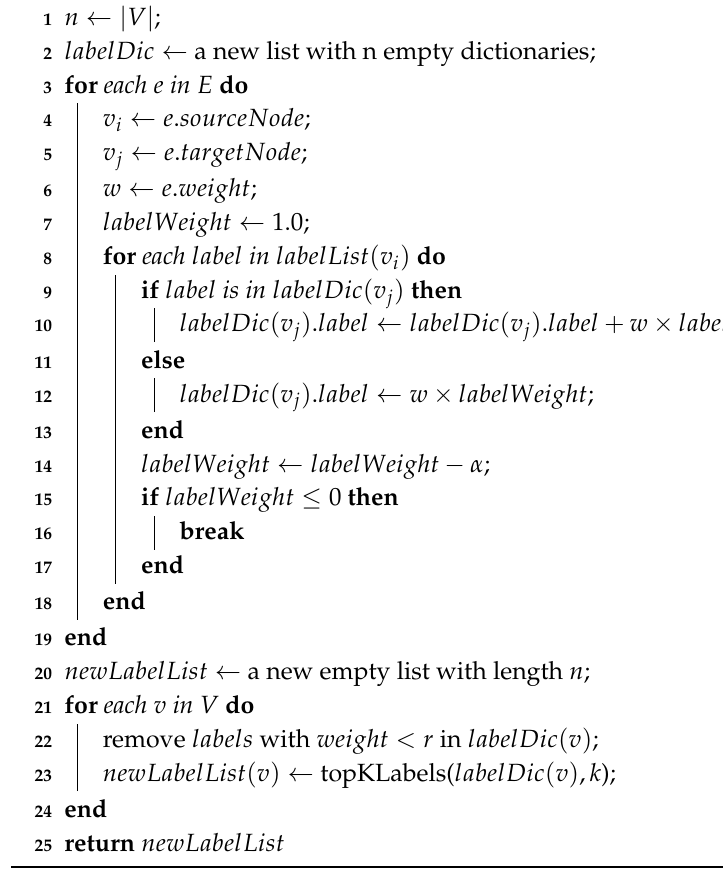
Algorithm 3: Multi label propagation ( V , E , labelList , k , r , α ).